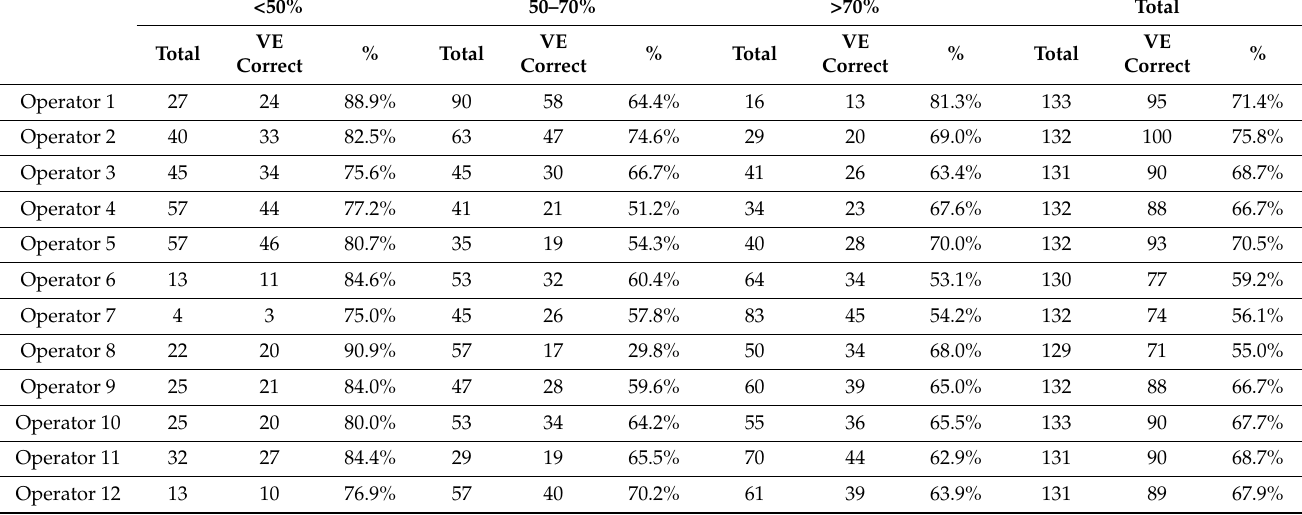
Table A2. Accuracy in predicting functional significance (FFR ≤ 0.8) based on visual estimation (VE) and stenosis